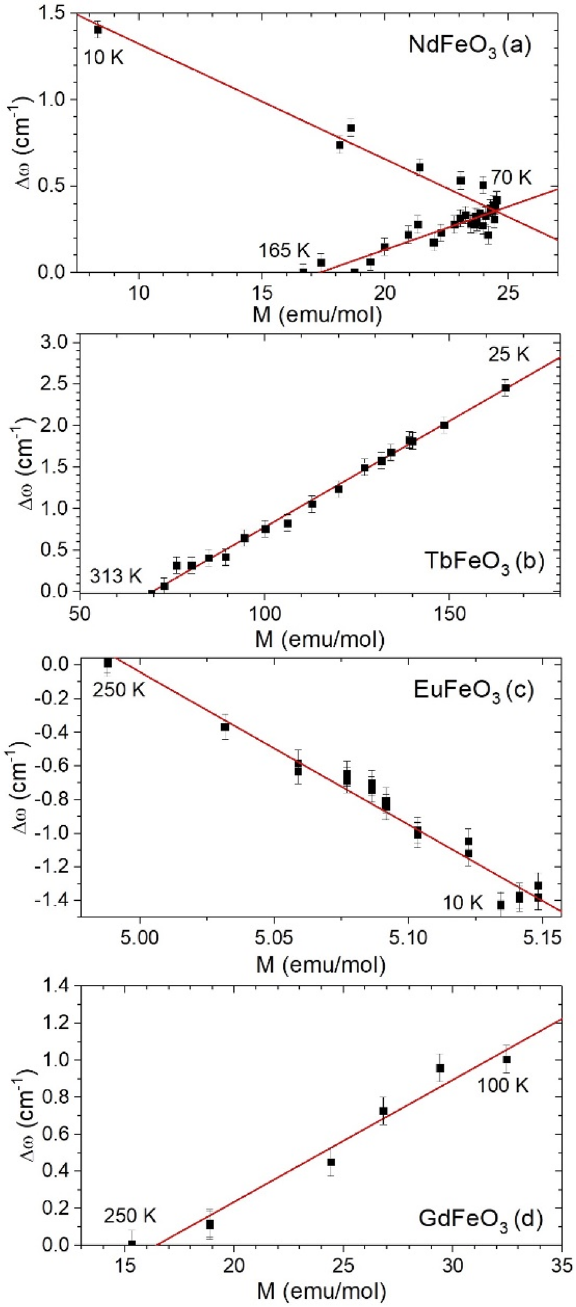
Figure 8. Anomalous contribution to the wavenumber of the [010] pc in-phase octahedra rotations of ( a )